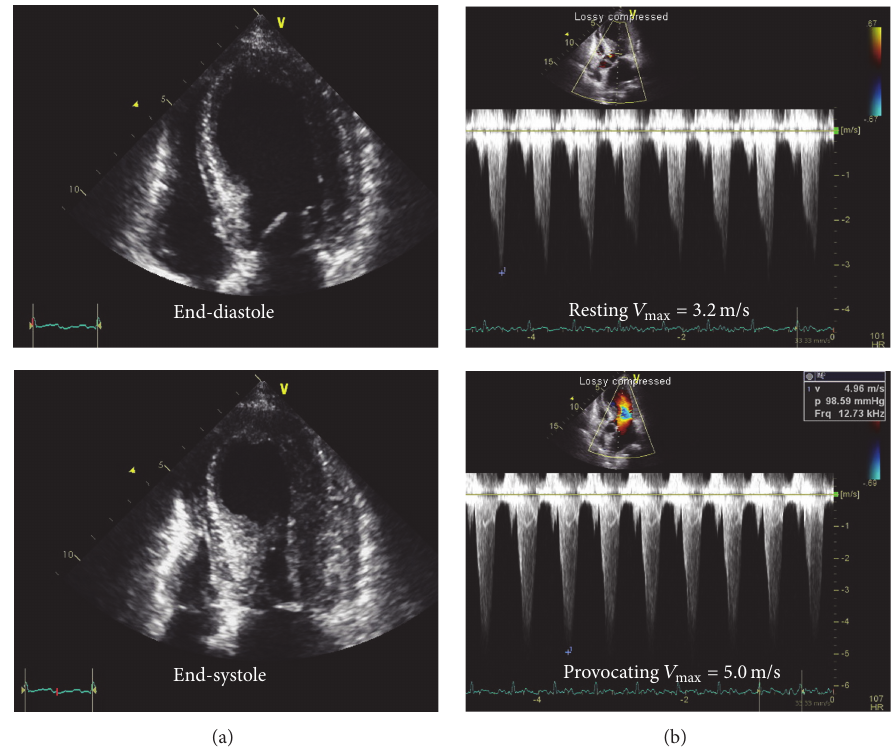
Figure 3: Transthoracic echocardiography showed an apical hypokinesia with normal left ventricular systolic function (a). Left ventricular outflow tract obstruction was confirmed by color flow acceleration with high-pressure gradient; maximal velocity ( 𝑉 max ) 3.2 m/s at resting and 5.0 m/s after Valsalva maneuver